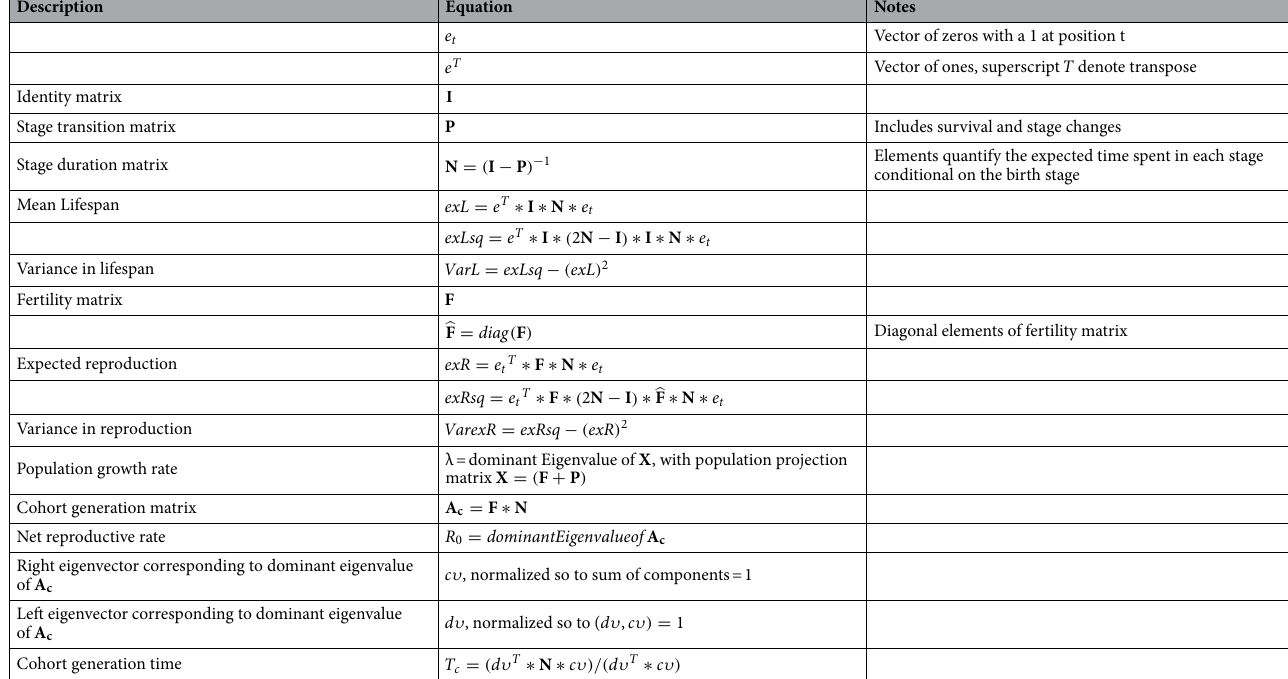
Table 2. Notation and equations. Details and proofs of equations are found elsewhere 21,73